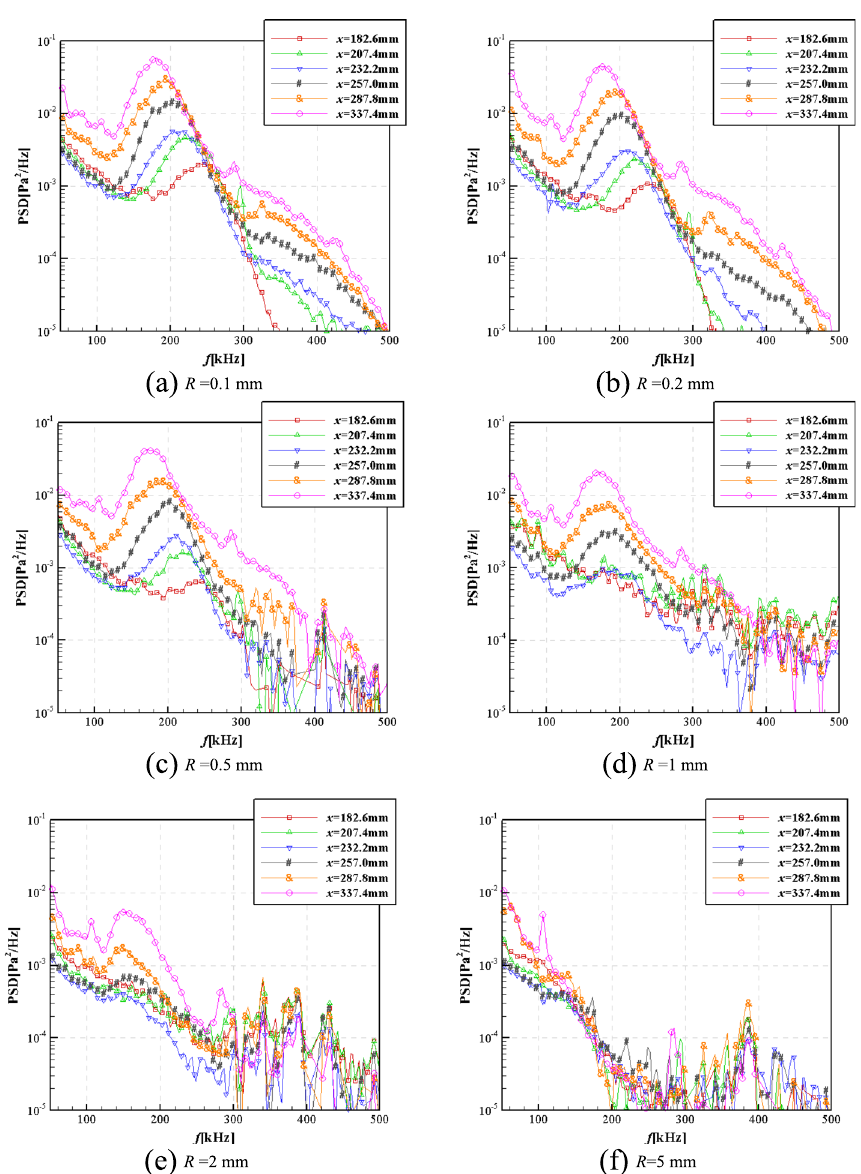
Fig. 7 PSD of wall pressure fluctuations at different cone bluntness. The wall temperature of the cone model is 300 K, the stagnation pressure of the wind tunnel is 4E tunnel is 454 K, and the corresponding Reynolds number is 4E